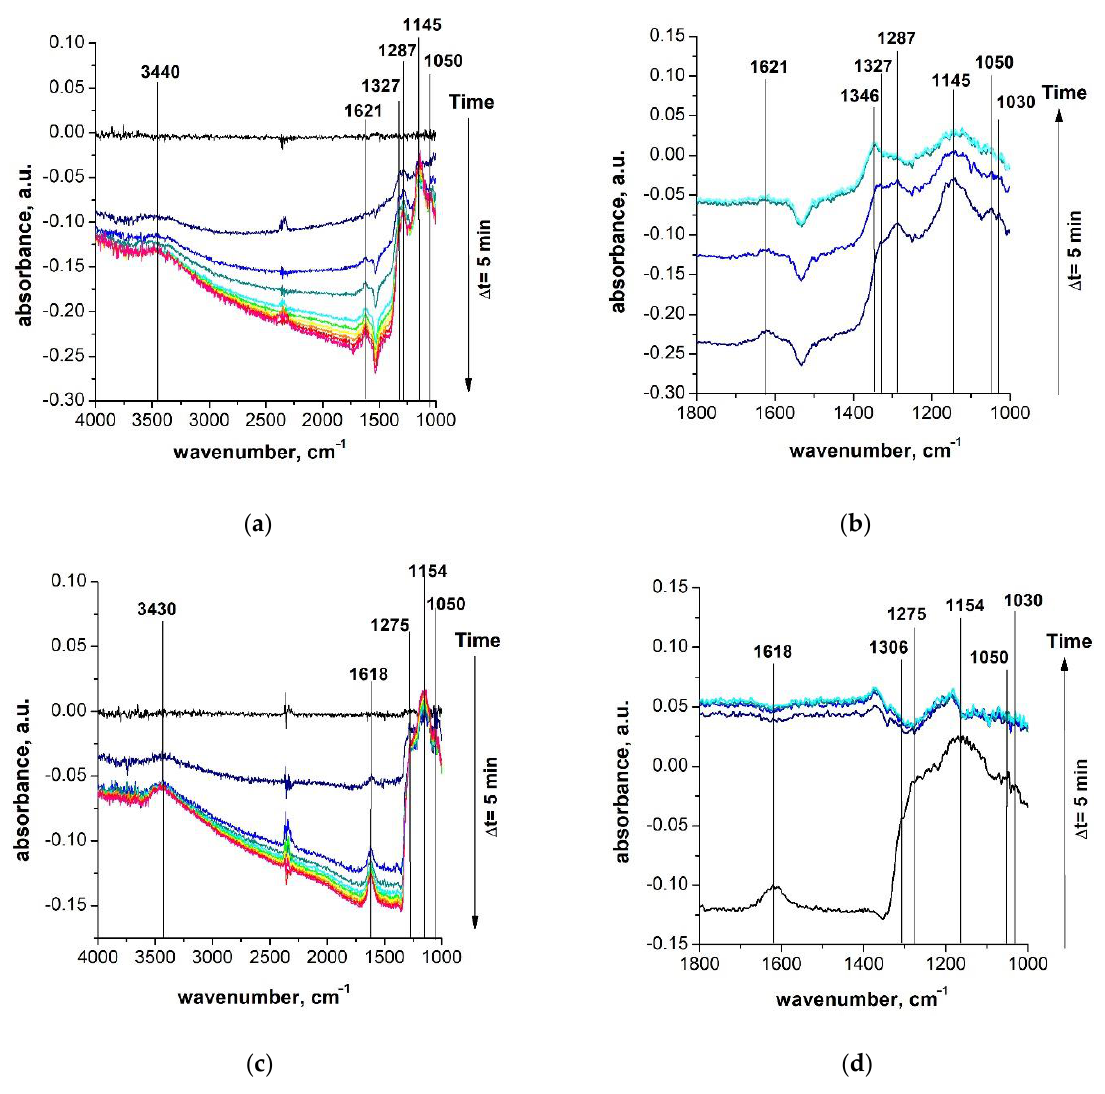
Figure 13. Ni 0.1 Co 2.9 O 4 DRIFT spectra: ( a ) 20 ppm H 2 S in dry air at 220 °C; ( b ) Annealing in dry air at 300 °C; ( c ) 20 ppm H 2 S in humid air (60% R.H.) at 220 °C; ( d ) Annealing in humid air (60% R.H.) at 300 °C.